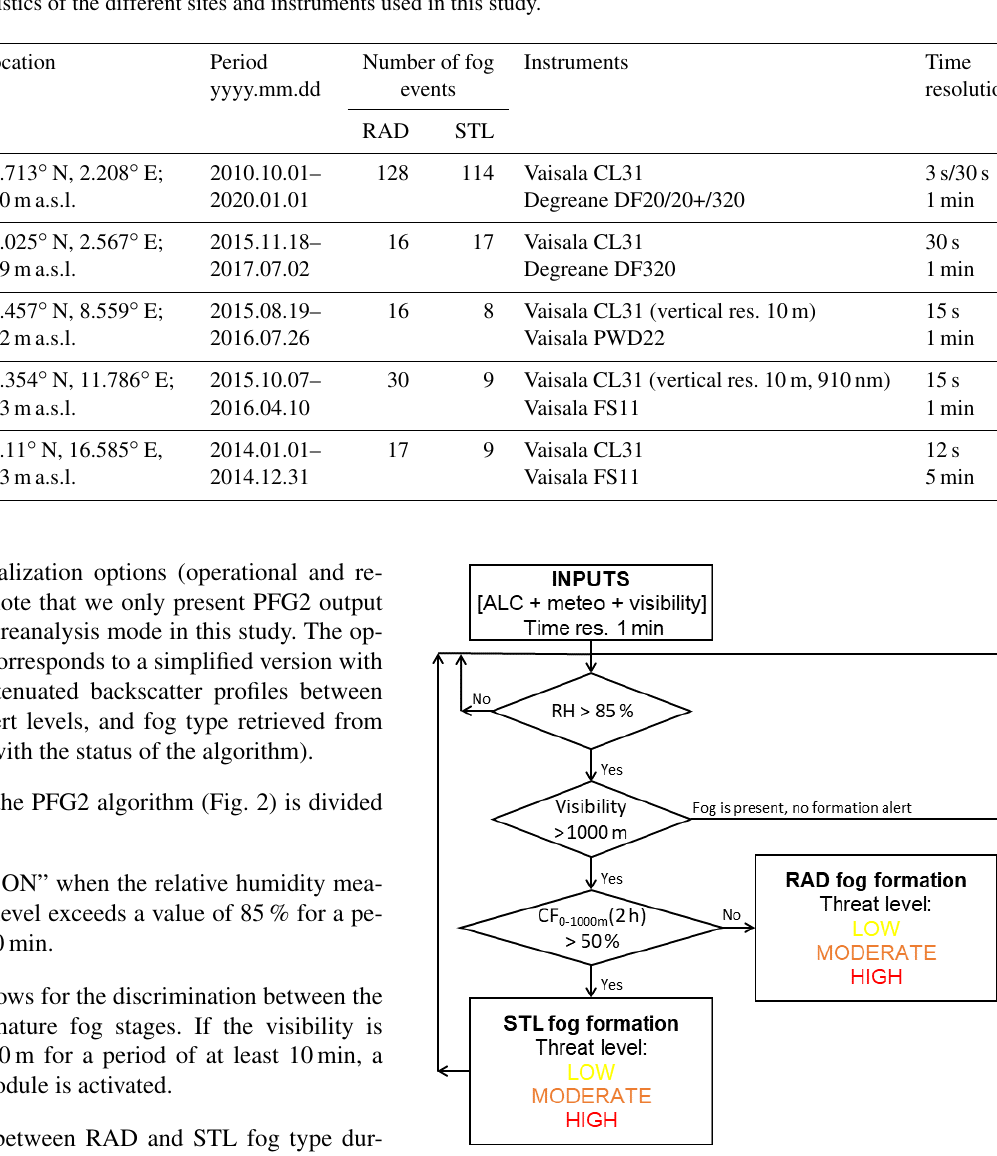
Table 1. Main characteristics of the different sites and instruments used in this study.